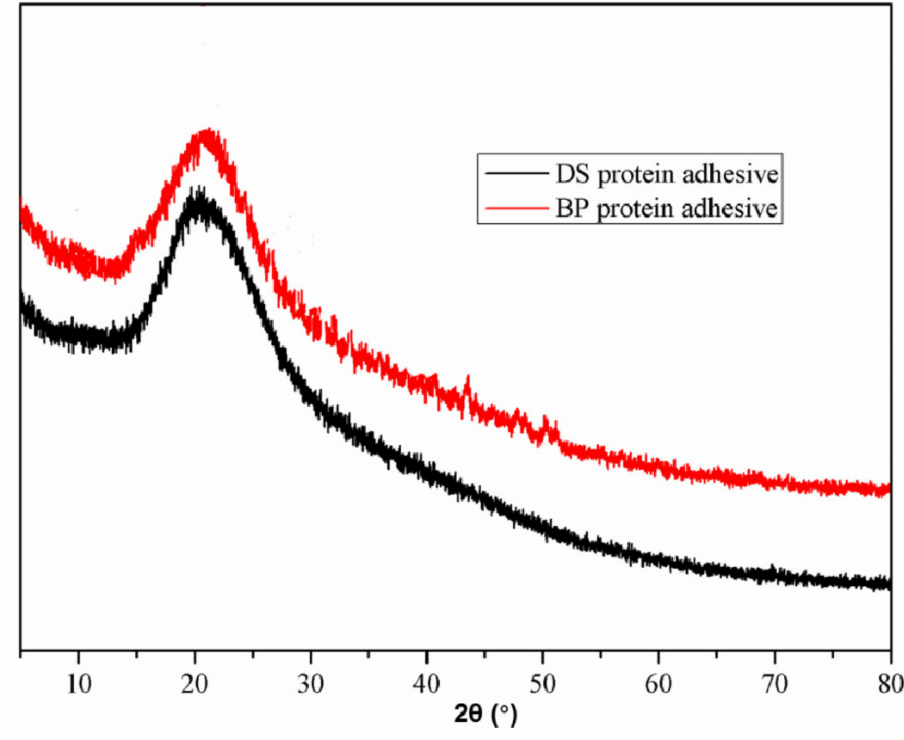
Figure 6. XRD spectrum of BP and DS protein